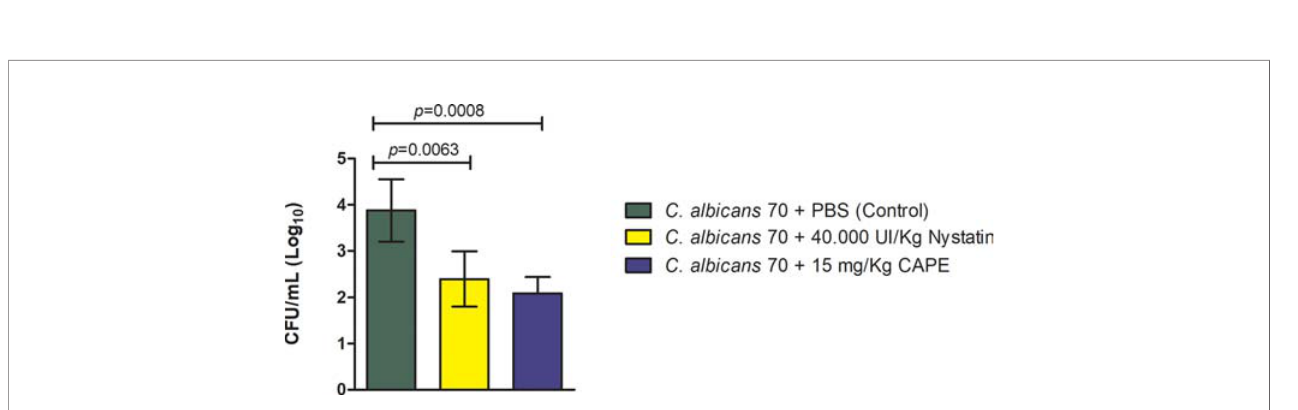
FIGURE 8 | CAPE decreased the number of fungal cells in G. mellonella hemolymph. Mean and SD of C. albicans counts (CFU/larvae) in the hemolymph of G. mellonella at 0 h and 24 h after treatment of CAPE. The following groups were compared at each time of infection: CA70 + PBS (untreated), CA70 + fl uconazole and CA70 + CAPE (5 mg/Kg). Treatment with CAPE was able to signi fi cantly reduce fungal burden in times evaluated, and fl uconazole only after 24 hours. Student ’ s t- test, p < 0.05.